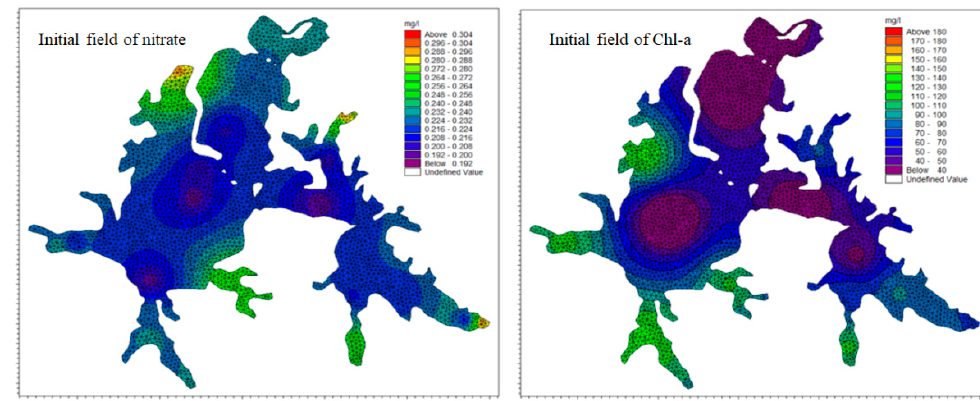
Figure 13. Replenishment of initial concentration field.